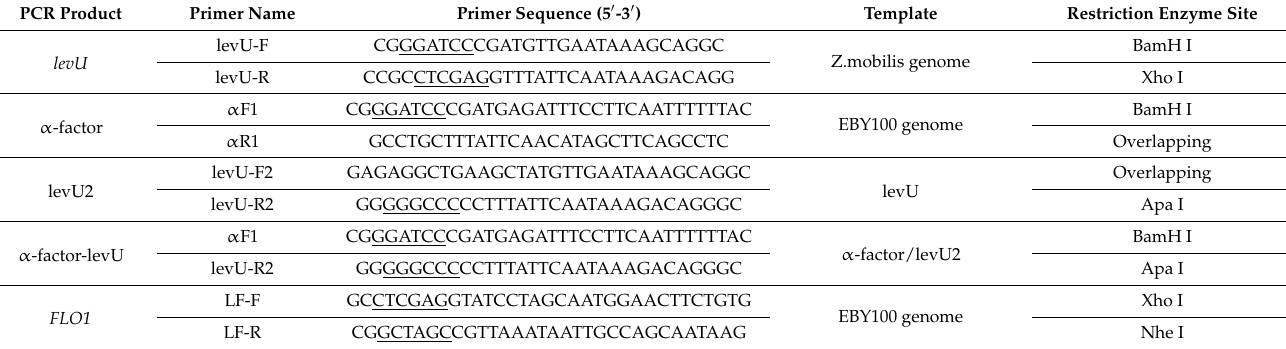
Table 2. Primers used in the present